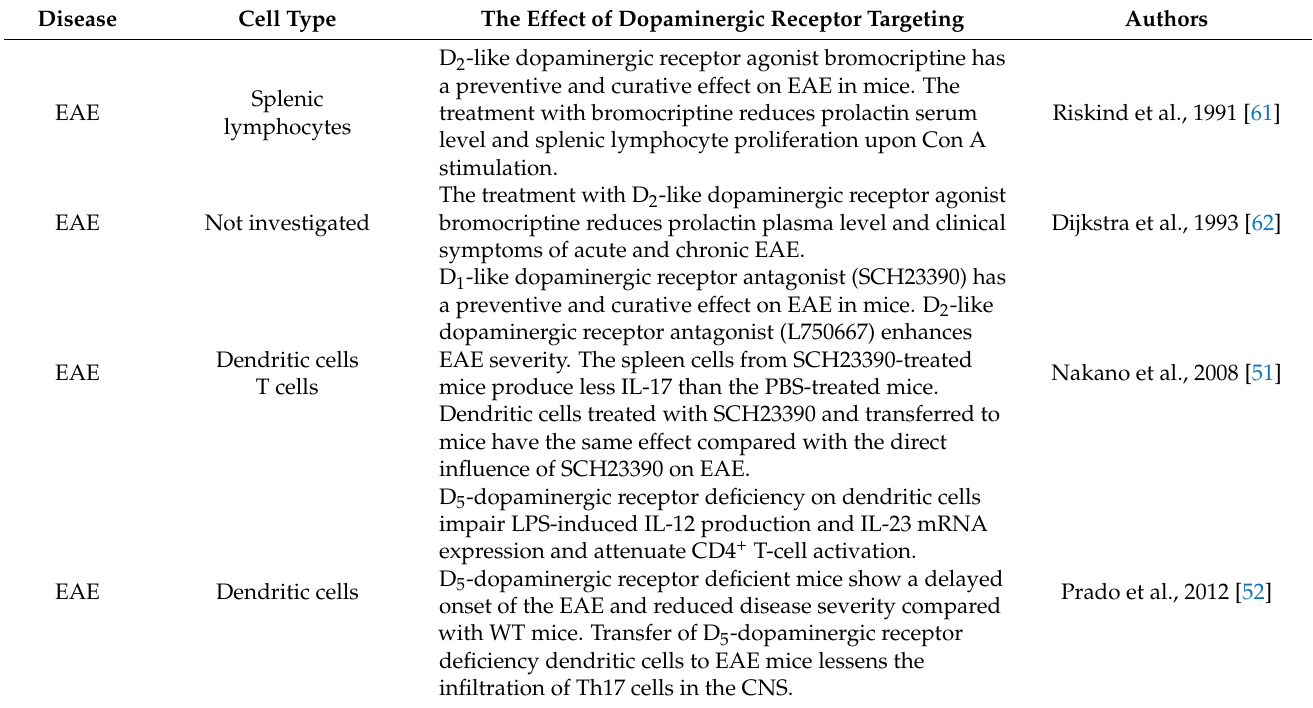
Table 1. The effect of dopaminergic receptor targeting on EAE/MS pathogenesis and course.